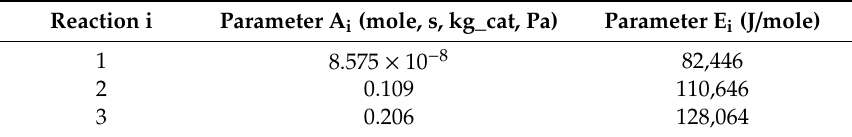
Figure 4. Forward rate constants k i from Table 5 for Reaction (Rxn) 1 (DR), 2 (RWGS), 3 (MD). Table 5. Arrhenius parameters for Table 3 from Figure 4 analysis; k i = A i exp [ − E i / ( RT )] .